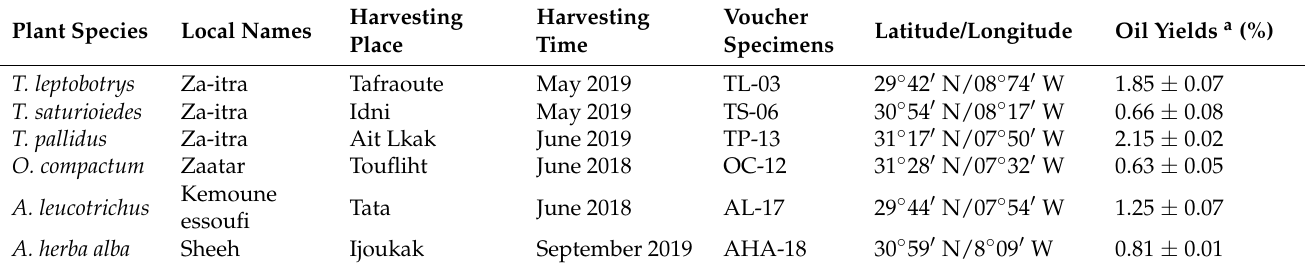
Table 1. Local names, harvesting location and period, voucher specimens and EO yield for the studied plants. Plant Species